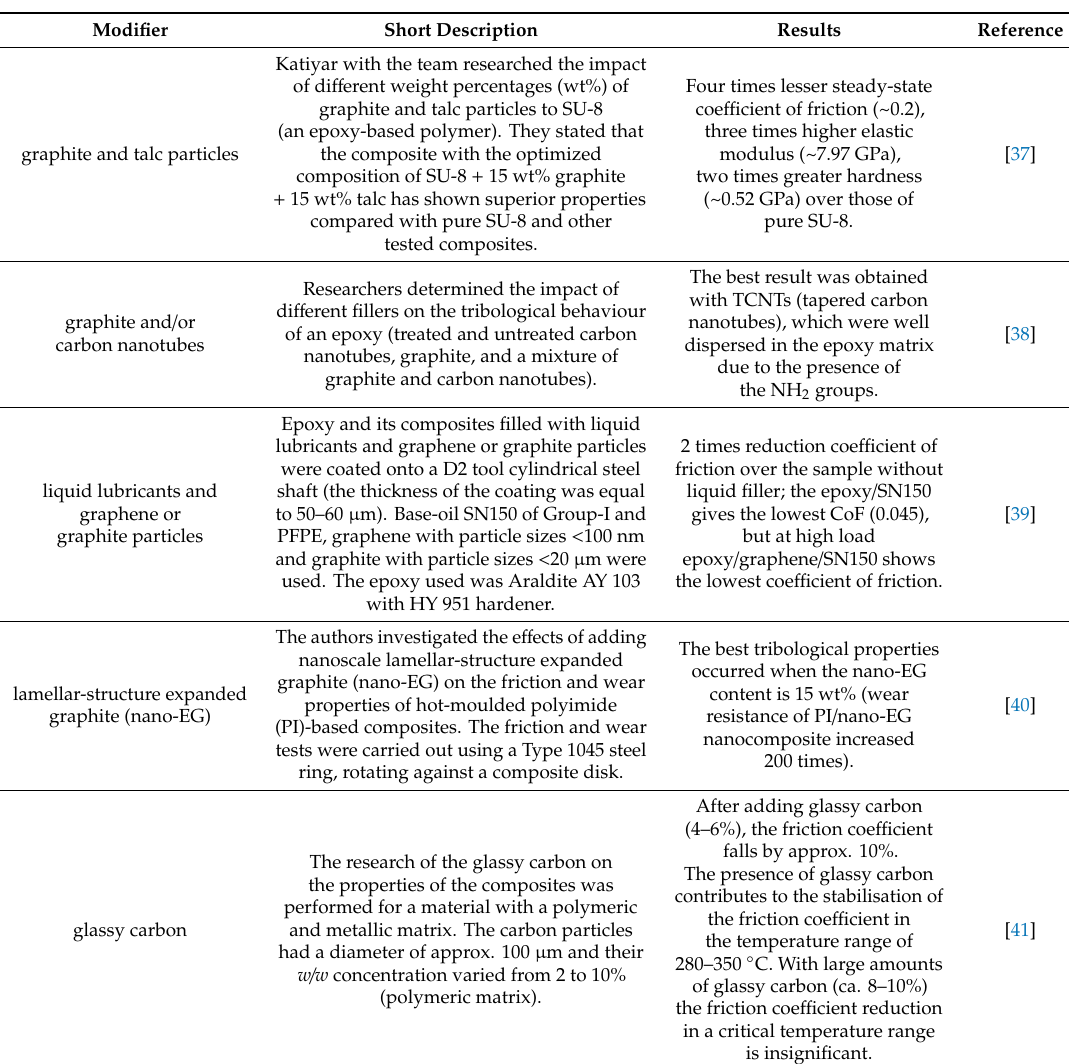
Table 1. A list of exemplary scientific studies on the influence of modifiers on the properties of composites